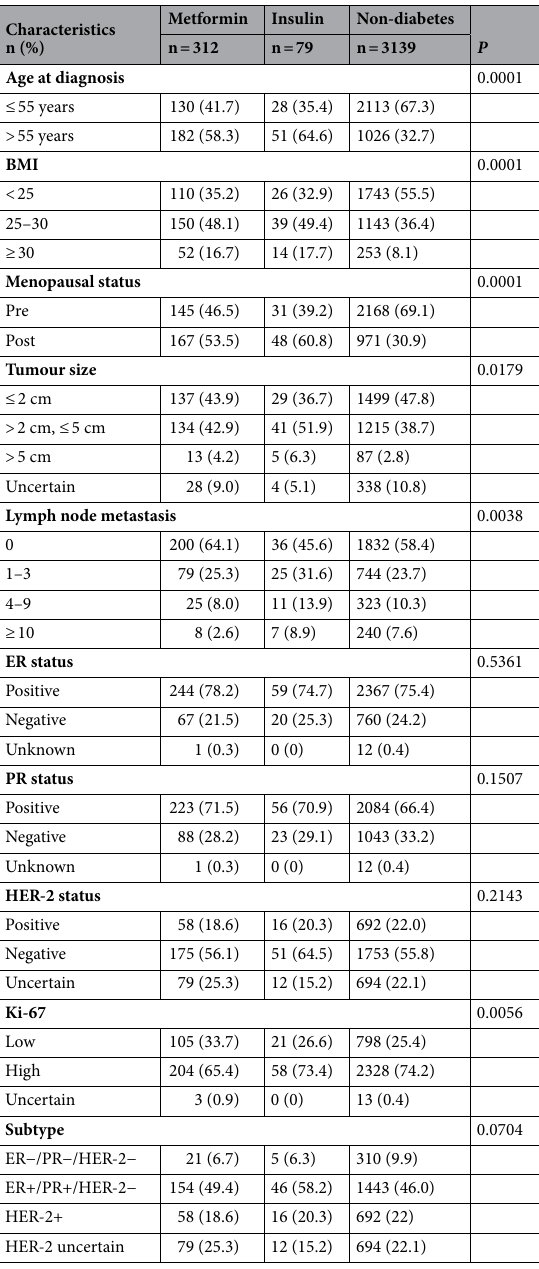
Table 1. Patients’ characteristics. BMI body mass index, IDC invasive ductal carcinoma, ILC invasive lobular carcinoma, ER estrogen receptor, PR progesterone receptor, HER-2 human epidermal growth factor receptor